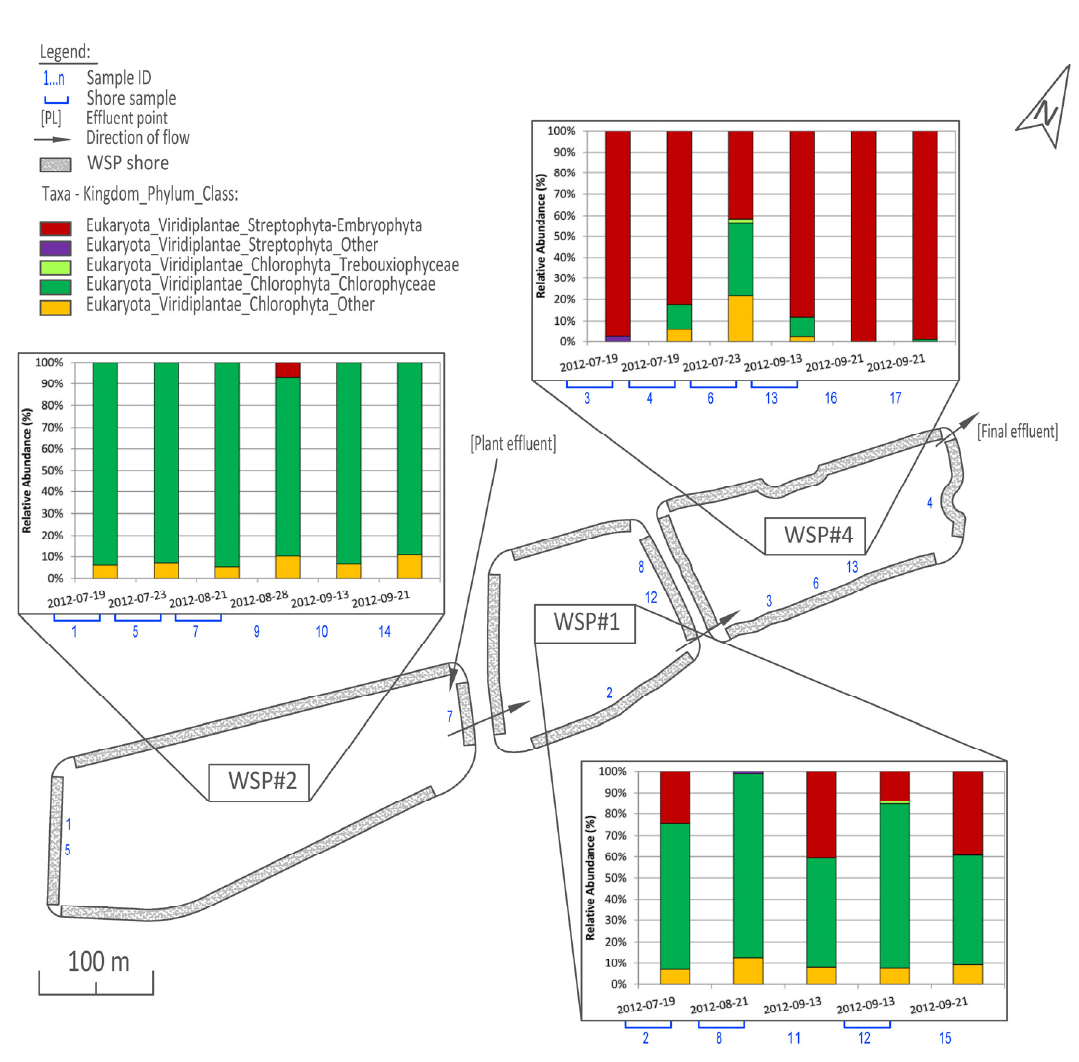
Figure 1. Spatial and temporal representation of the relative abundance of eukaryotic species in the WSPs at the Amherstview WPCP over the July to September 2012 sampling